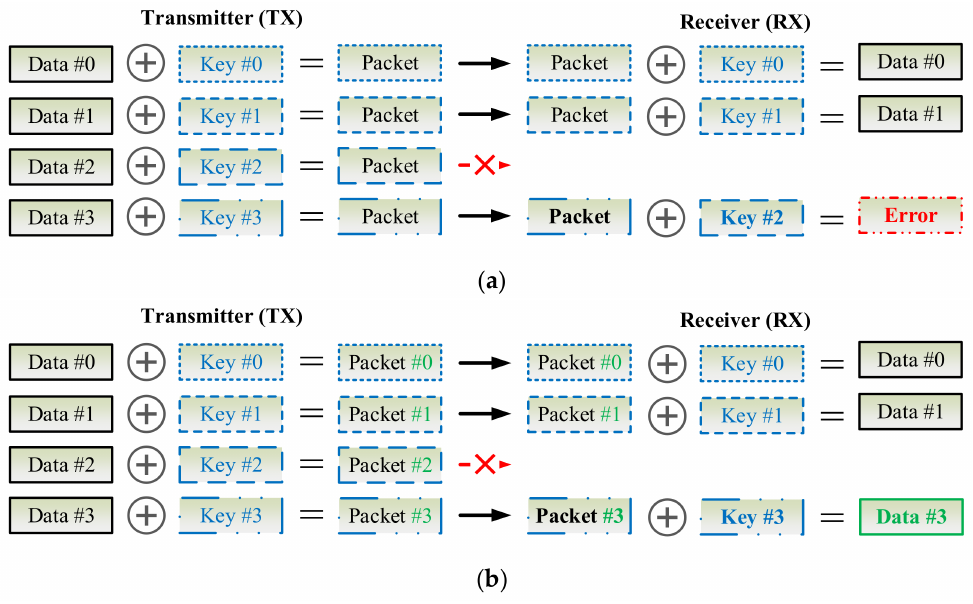
Figure 10. Scenarios where packets are transmitted through an unreliable transport ( a ) cause a key synchronization problem or ( b ) are patched by a basic solution to skip the key of the lost packet.